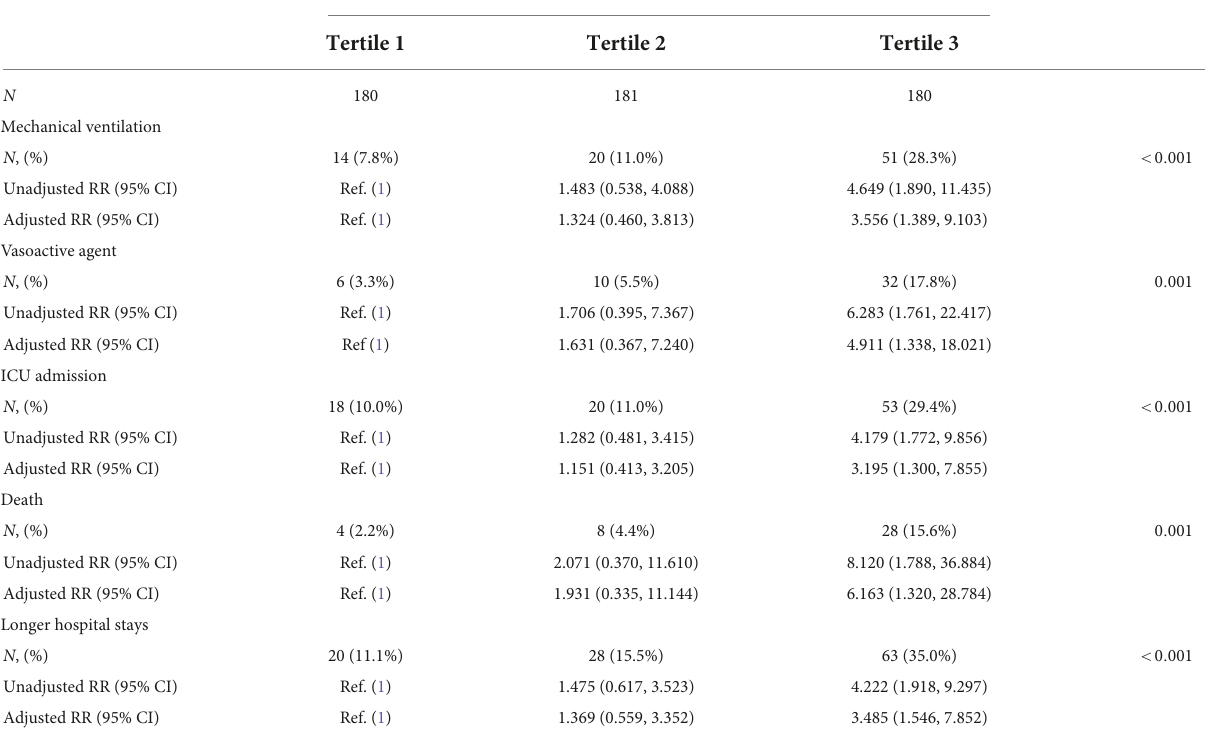
RR:Relativerisk. Thelengthofhospitalstaywasdividedintotwogroups:longerhospitalstays, ≥